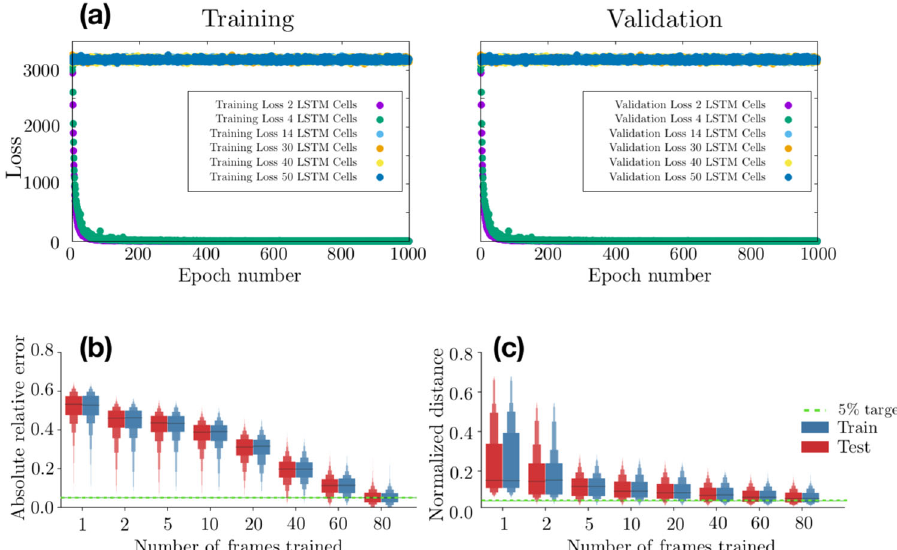
Fig. 3 LSTM architecture and calibration. a Learning curves as a function of the number of epochs for both training and validation sets. b Accuracy of the LSTM network for the absolute relative error, ARE ð k Þ t i ð Þ , as a function of the number of frames used for training. c Accuracy of the LSTM network for the normalized distance, D ð k Þ t i ð Þ , as a function of the number of frames used for training. In b and c , the dashed green line indicates the 5% error value, while the black lines indicate the mean value of the absolute relative error and normalized distance respectively at various frames t i .